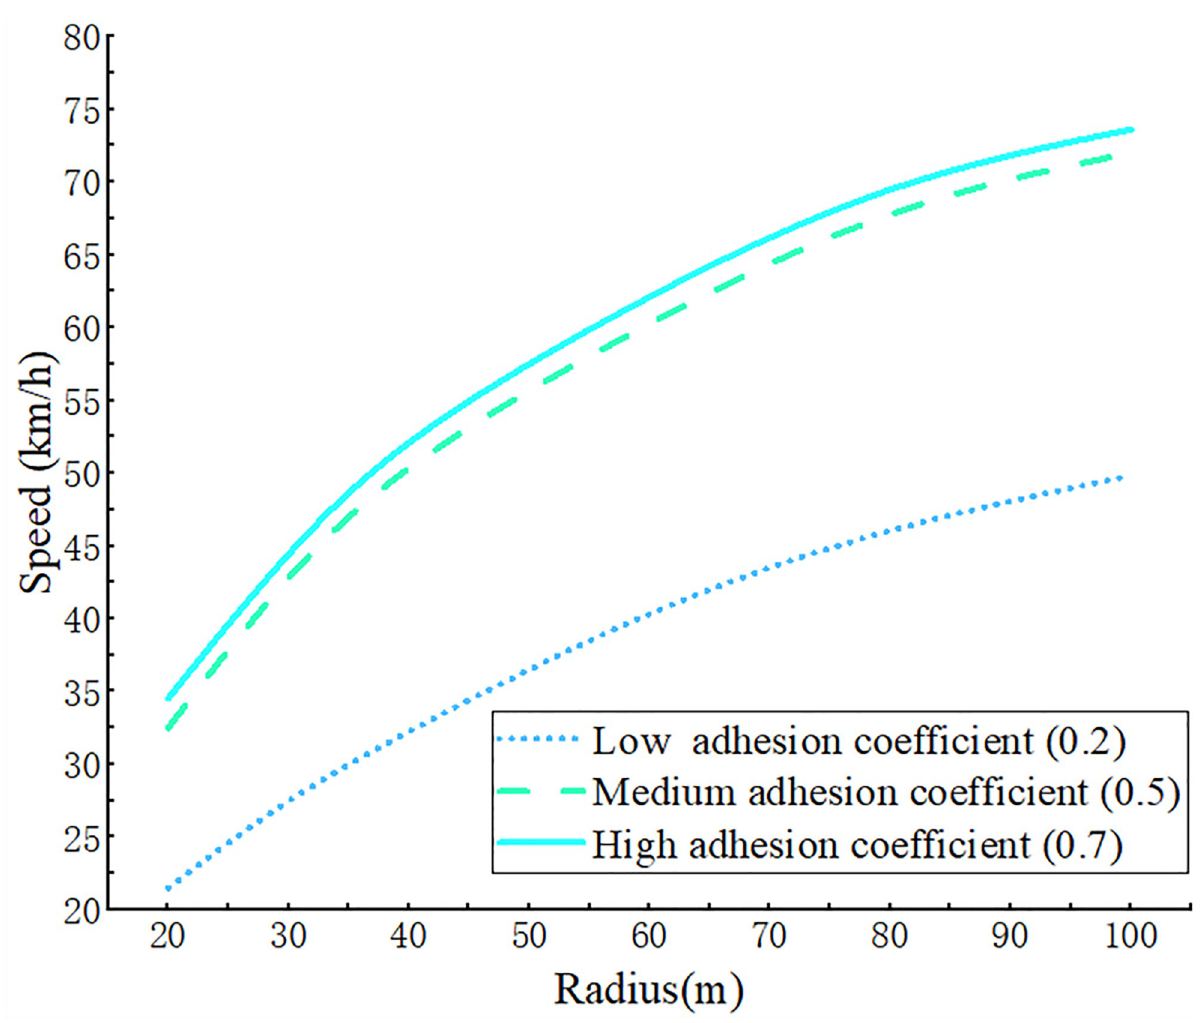
Fig 13. The curve of vehicle driving instability speed threshold corresponding to different road turning